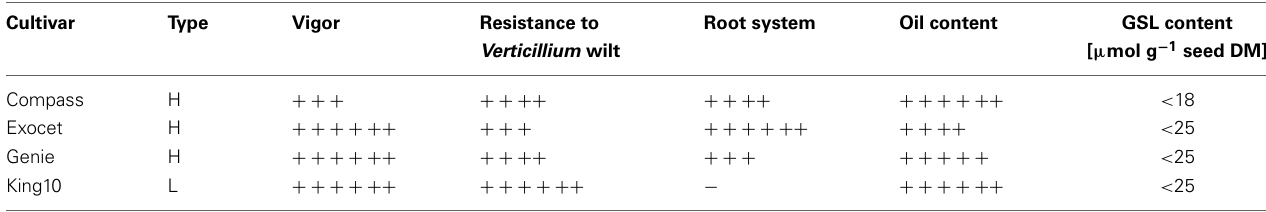
Table 1 | Summary of available data about the different cultivars.